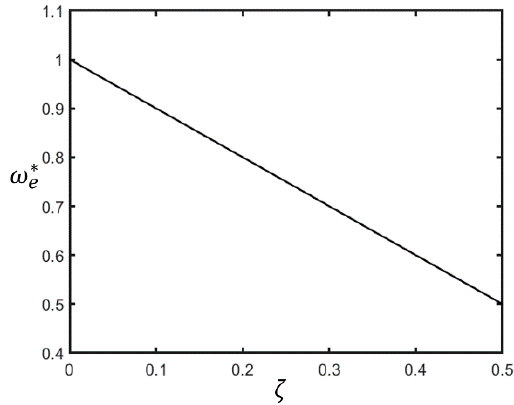
Figure 9. Variation of (cid:2033) (cid:3032)∗ with (cid:2014) for PDC in the electric circulation mode.